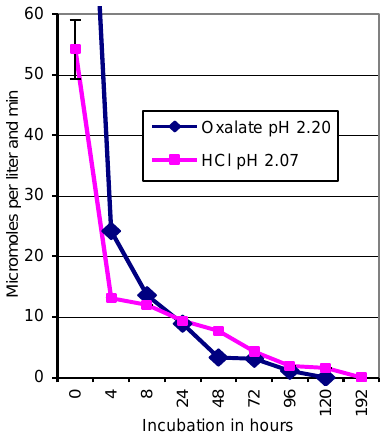
Figure 3. Oxidation of ABTS (µmol L −1 min −1 ) finally added to culture fluid samples of Km 10 which had been pre-incubated at pH 2.20/2.07 in phosphate-oxalate/phosphate-HCl buffer for up to 192 h. Initial enzyme activity in phosphate-oxalate buffer at zero hours, 628 ± 70 µmol L −1 min −1 . Error bar, ± SD ( n = 3).